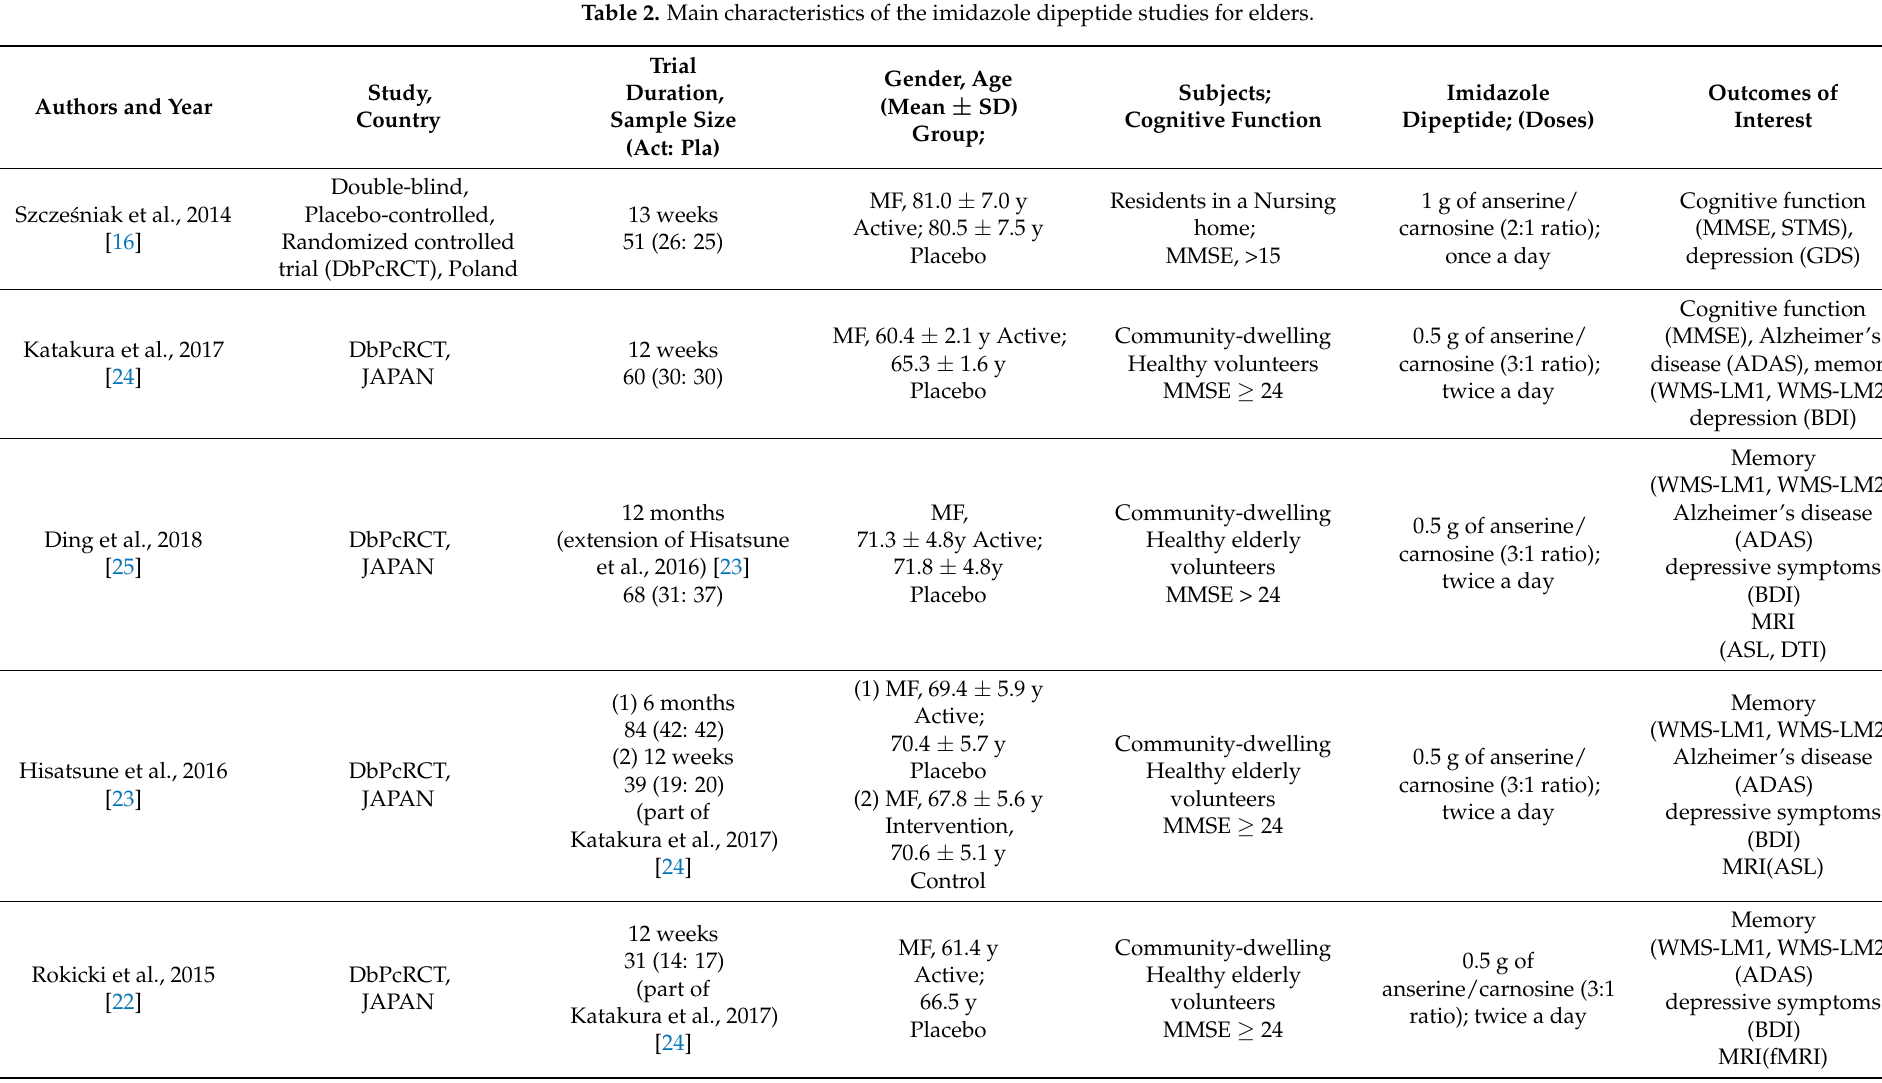
Table 2. Main characteristics of the imidazole dipeptide studies for